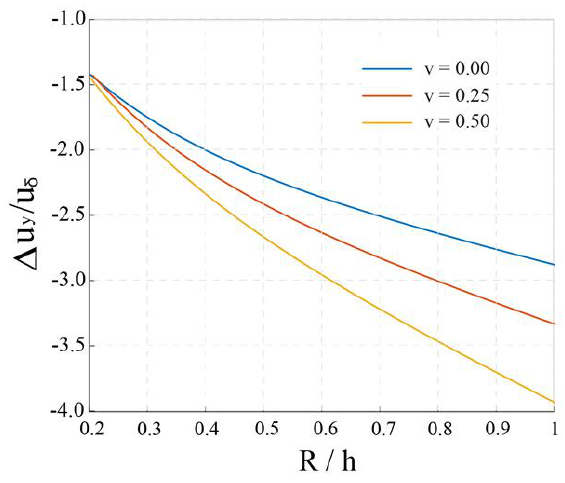
Figure 16. Vertical translation.